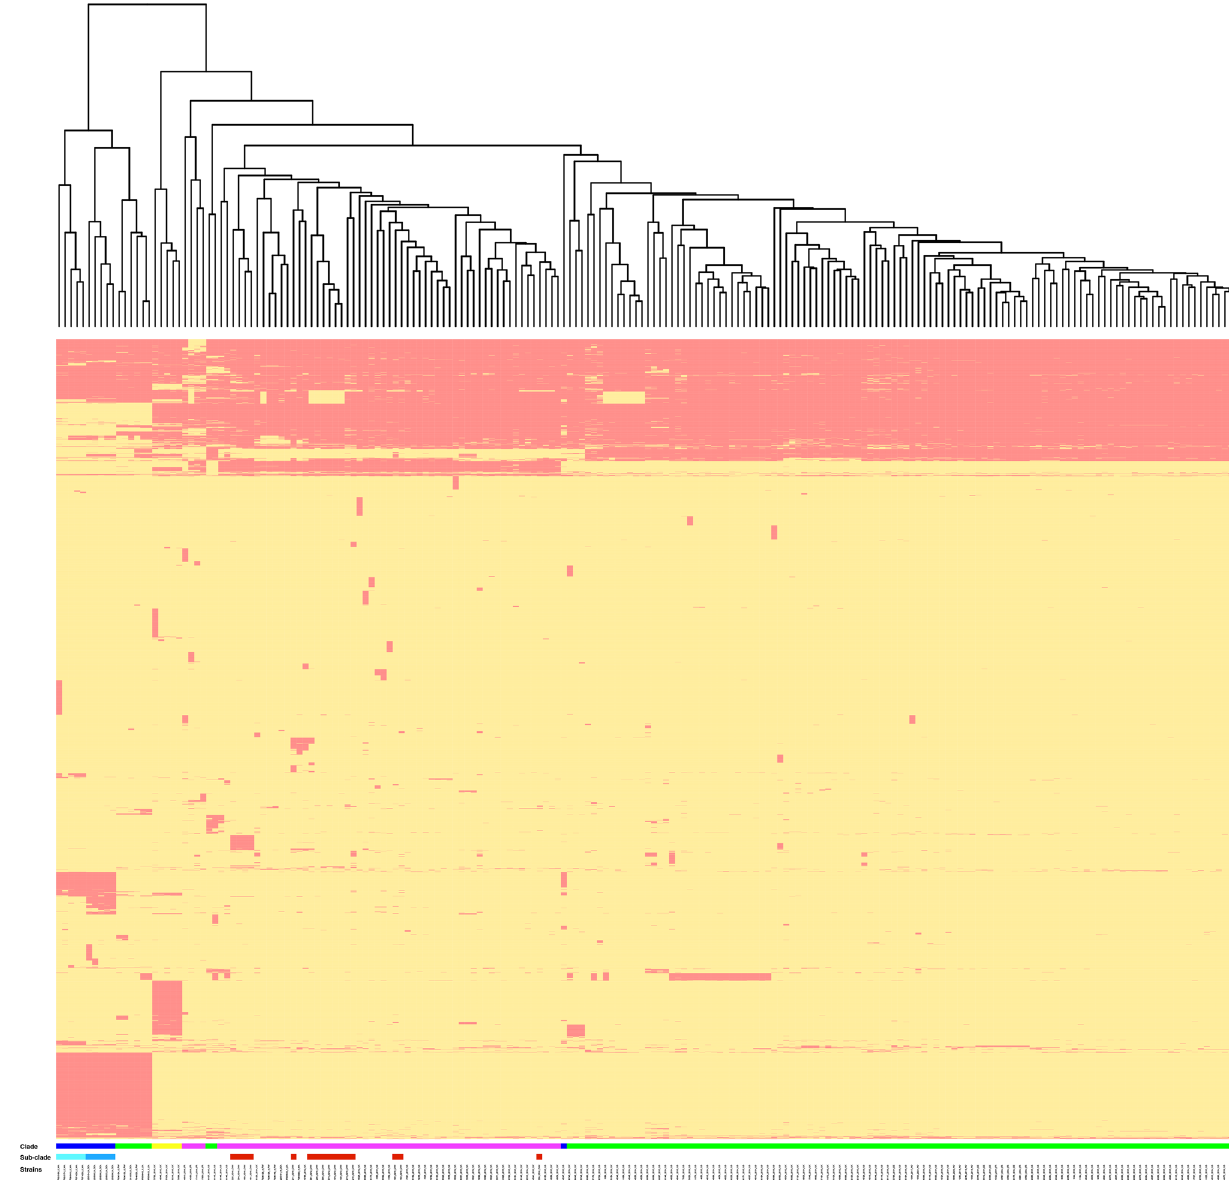
Figure 5. Heatmap of gene presence (red) and absence (yellow) in the accessory genomes. The cluster diagram on the top is based on the presence/absence matrix. Clade and sub-clade that each isolate belonged to in the phylogenetic tree was color